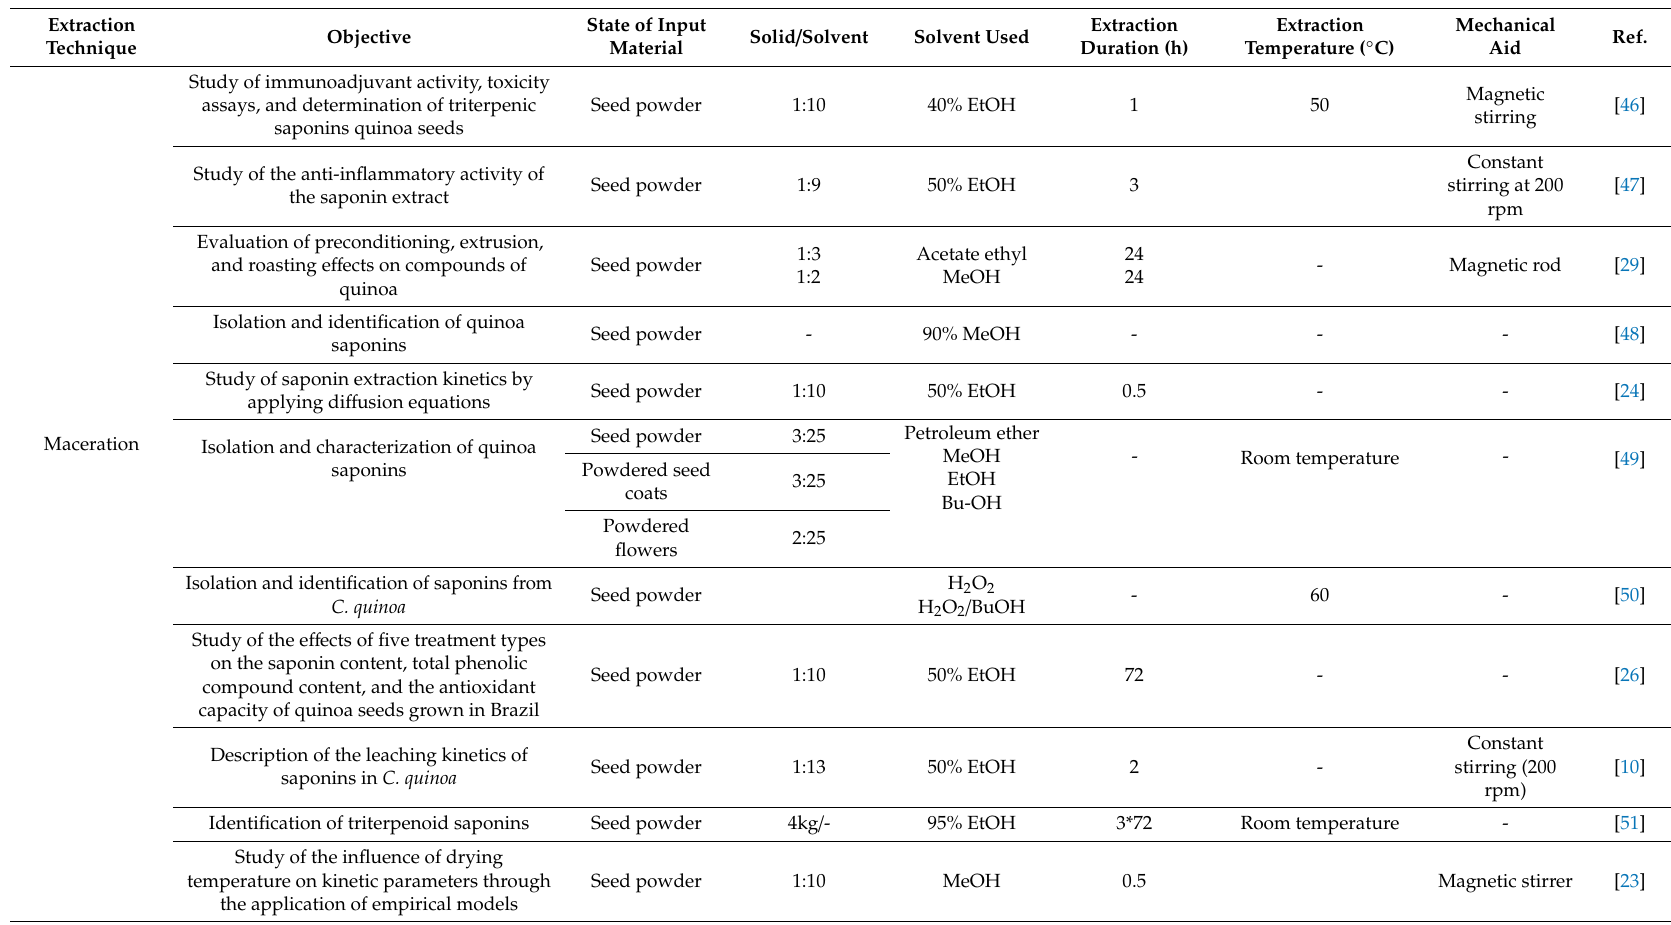
Table 2. Summary of saponin extractions methods of C.